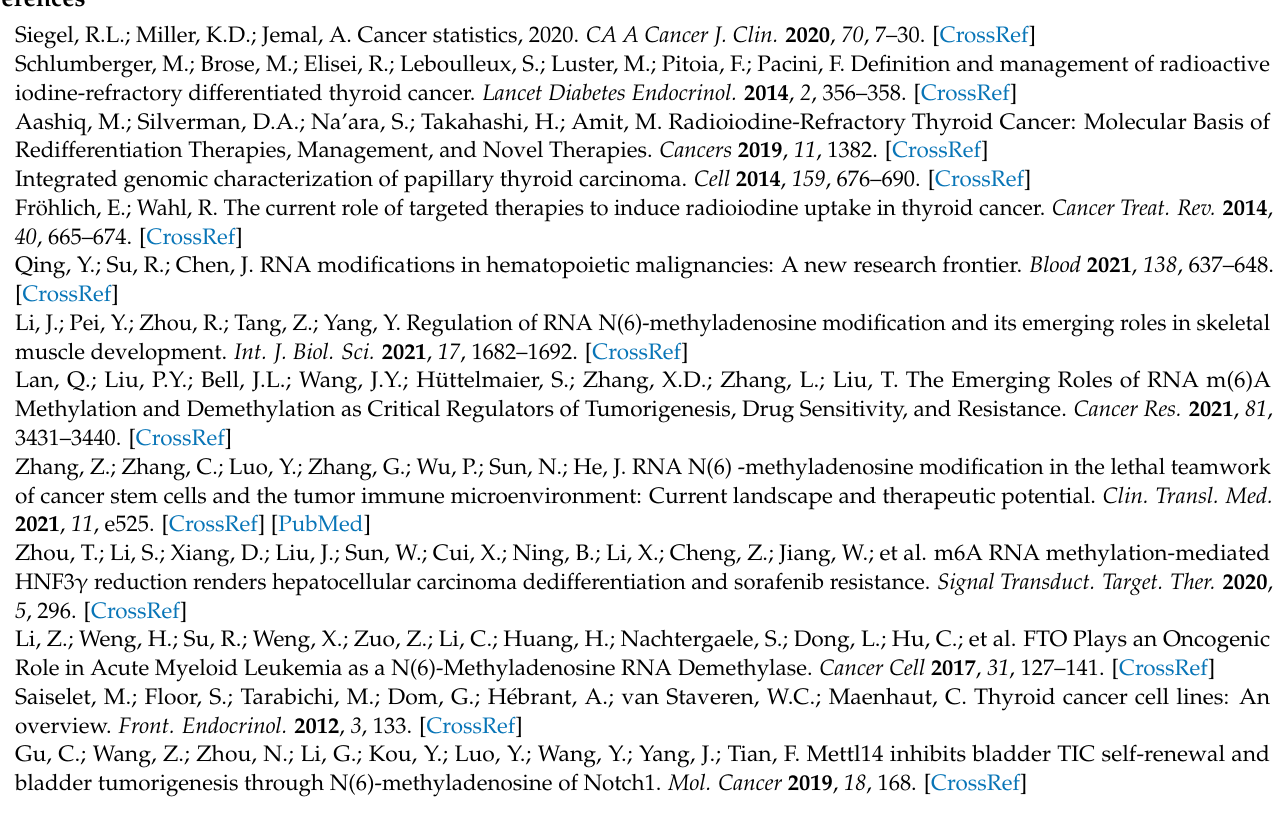
Table S2: Expression of m6A key regulators and iodide-handling genes in normal thyroid tissues and thyroid cancer based on TCGA database; Table S3: Pearson correlation between SLC5A5 and top 30 genes from RNA-seq associated with cell differentiation of malignant